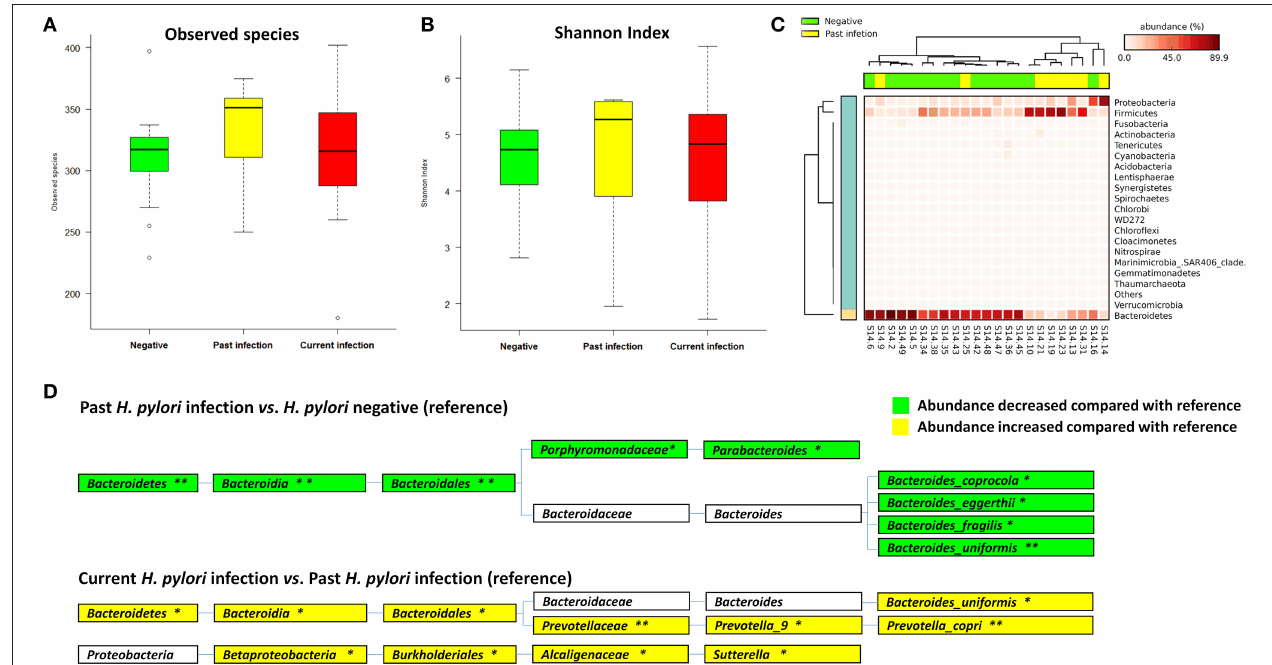
FIGURE 2 | Associations between Helicobacter pylori infection and fecal microbiota. (A) Boxplot of observed species in different H. pylori status groups. The boxes indicate interquartile ranges (IQRs) and the median (blank line).Whiskers extend to the most extreme points within 1.5-fold IQR. Outliers are plotted individually ( ◦ ). (B) Shannon index in different H. pylori status groups. (C) Heat-map of relative abundance distributions of the phyla in past H. pylori infection ( n = 8) and negative groups ( n = 15). (D) Cladogram of differently distributed taxa between groups. The differential taxa are illustrated between past H. pylori infection and negative groups, or current H. pylori infection and past infection groups as * p < 0.05 and ** p < 0.01, respectively.